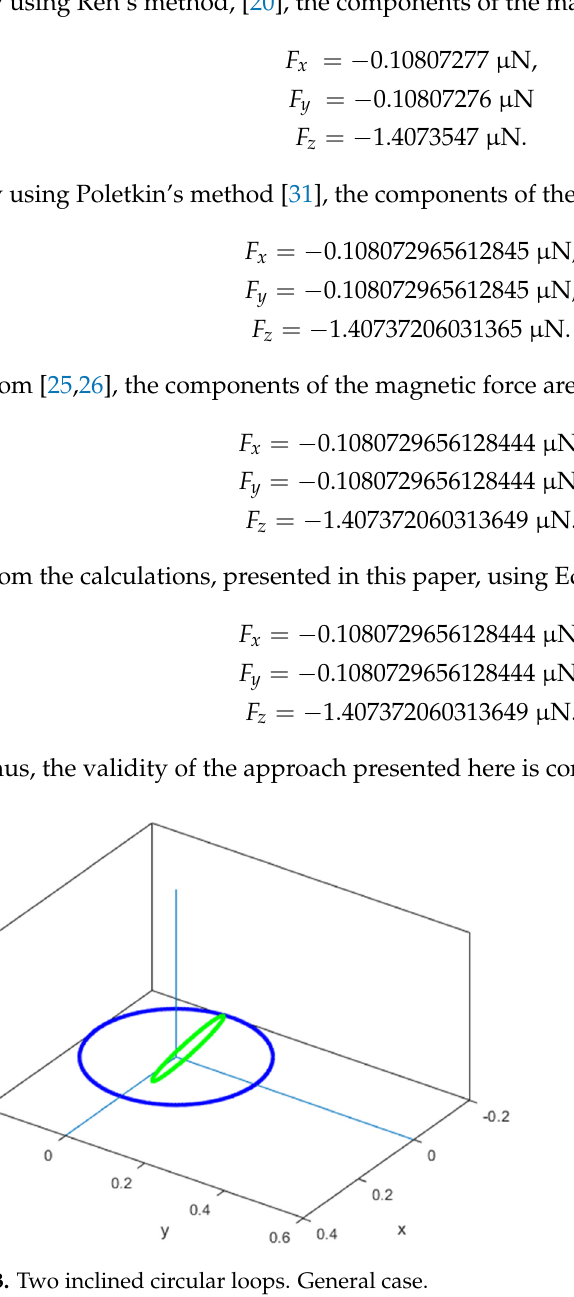
Figure 3. Two inclined circular loops. General case.